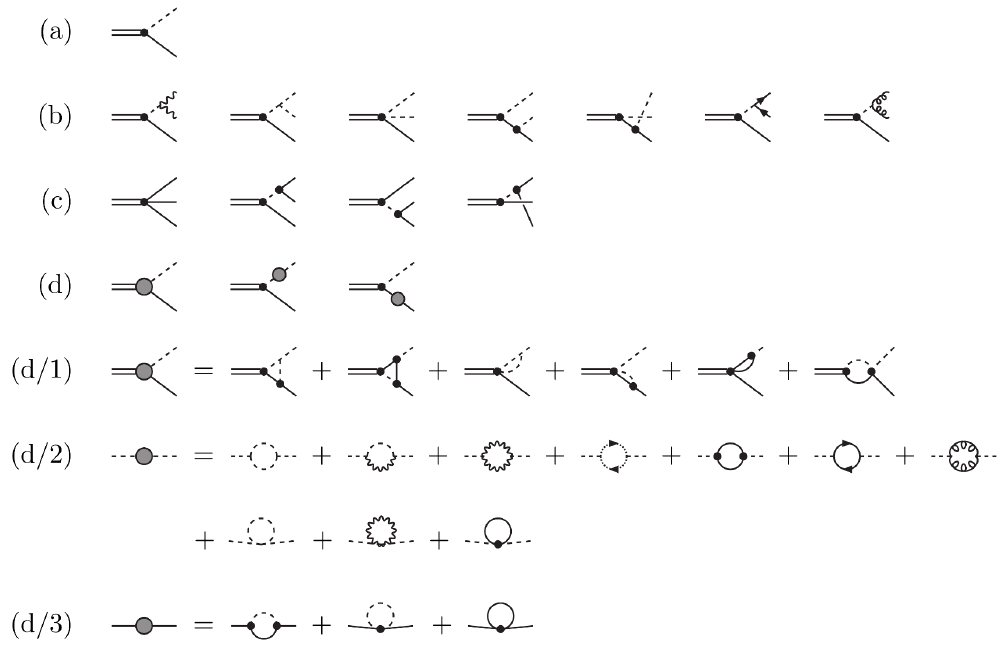
JHEP01(2023)157 Figure 1 . Amplitudes for the decay and/or production of a ϕ -particle (denoted by a double line). Many of these processes are kinematically forbidden, but this is inessential, as we only use them for extracting matrix elements squared; crossings lead to allowed processes, e.g. 2 ↔ 2 scatterings, or 1 ↔ 2 decays or inverse decays between a Higgs boson and two ϕ -particles. Dashed lines denote Higgs fields, wiggly lines weak gauge bosons, arrowed lines fermions, curly lines gluons, and straight lines thermalized singlet modes, denoted by ϕ in section 3. Only physical particles (no Goldstones) e are shown as final states. The small blobs denote non-Standard Model couplings, and the gray blobs virtual corrections. The amplitudes have been classified as: (a) 1 → 2 processes; (b) 1 → 3 processes with two singlets; (c) 1 → 3 processes with four singlets; (d) virtual corrections to 1 → 2